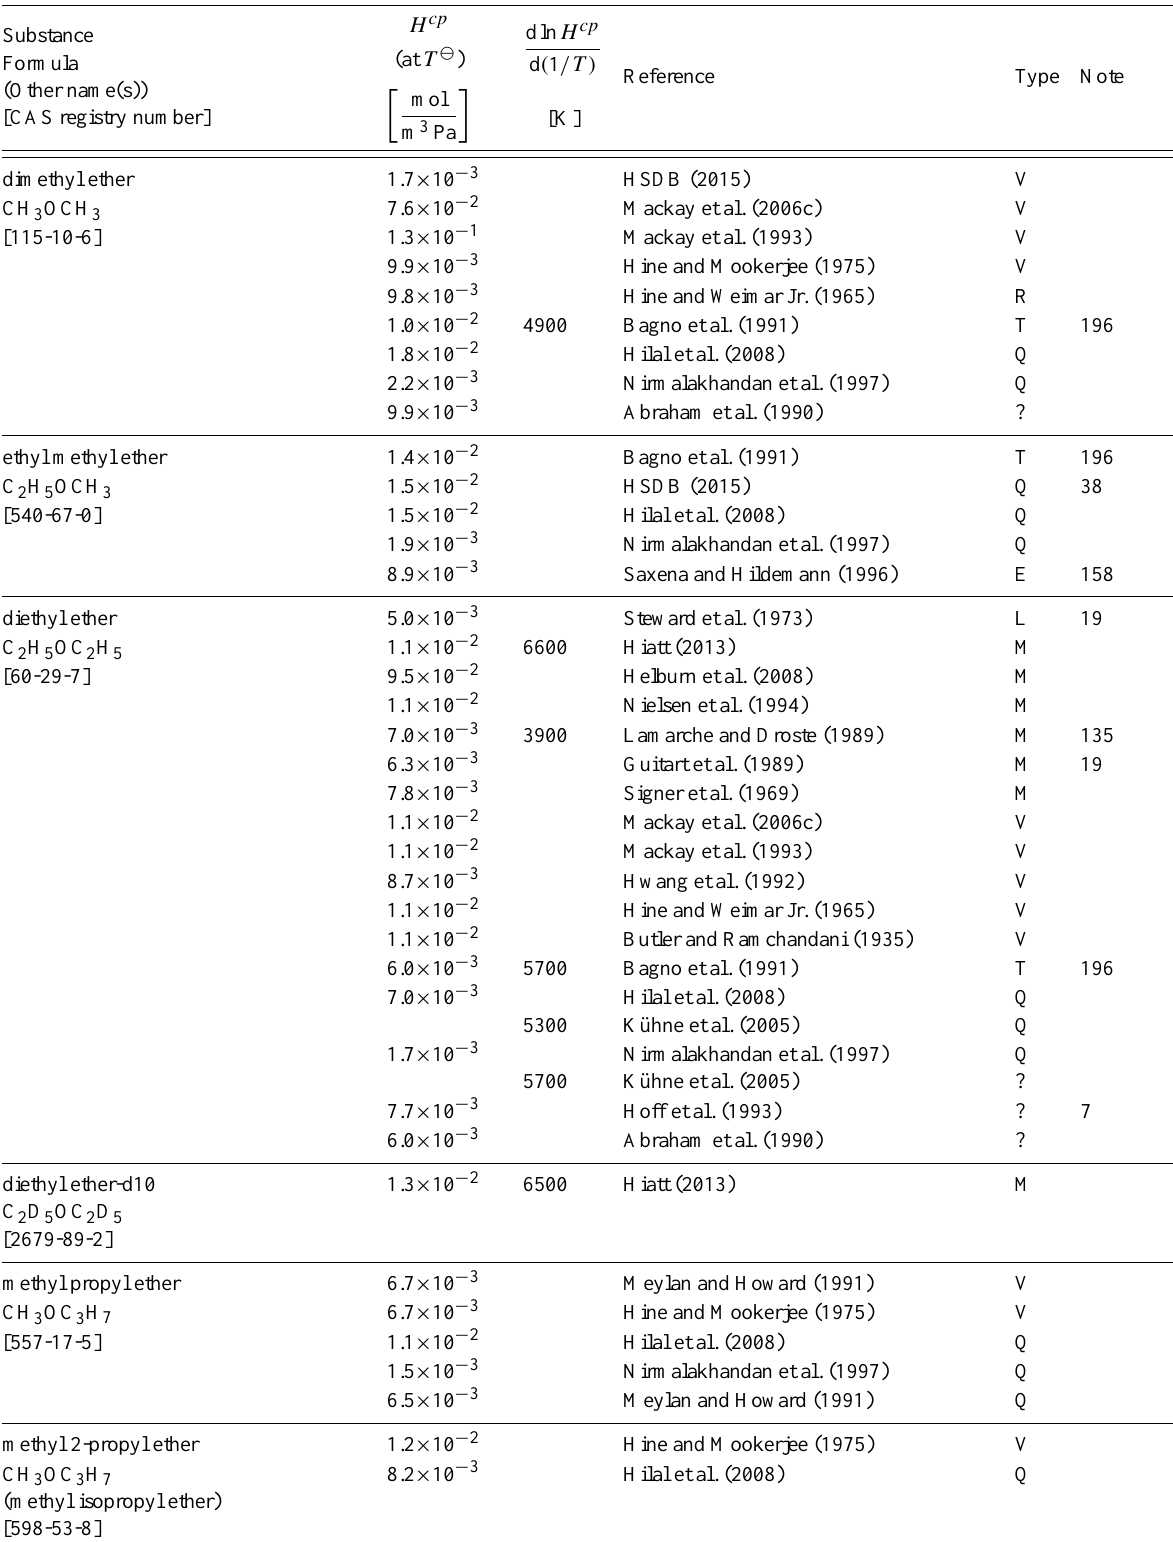
Table 6: Henry’s law constants for water as solvent